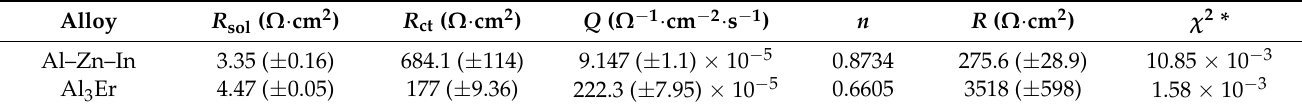
Figure 15. EIS of Al–Zn–In and Al 3 Er alloys. Table 6. Fitting values of